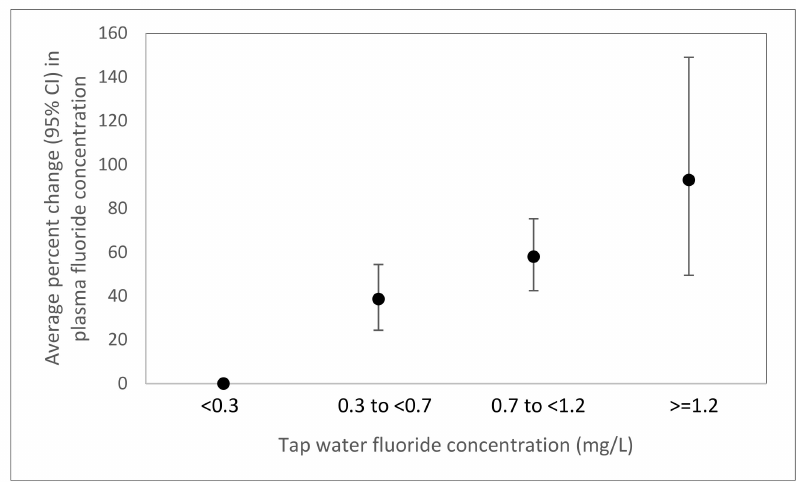
Figure 3. Adjusted percent change (95% confidence interval) in plasma fluoride per fluoride concentration of home tap water ( < 0.3 mg / L, n = 647; 0.3 to < 0.7 mg / L, n = 613; 0.7 to < 1.2 mg / L, n = 507; ≥ 1.2 mg / L, n = 53) in 1820 6–19 year old National Health and Nutrition Examination Survey participants from 2013–2016 who consumed tap water. Adjusted for age, sex, race / ethnicity, and recent green / black tea